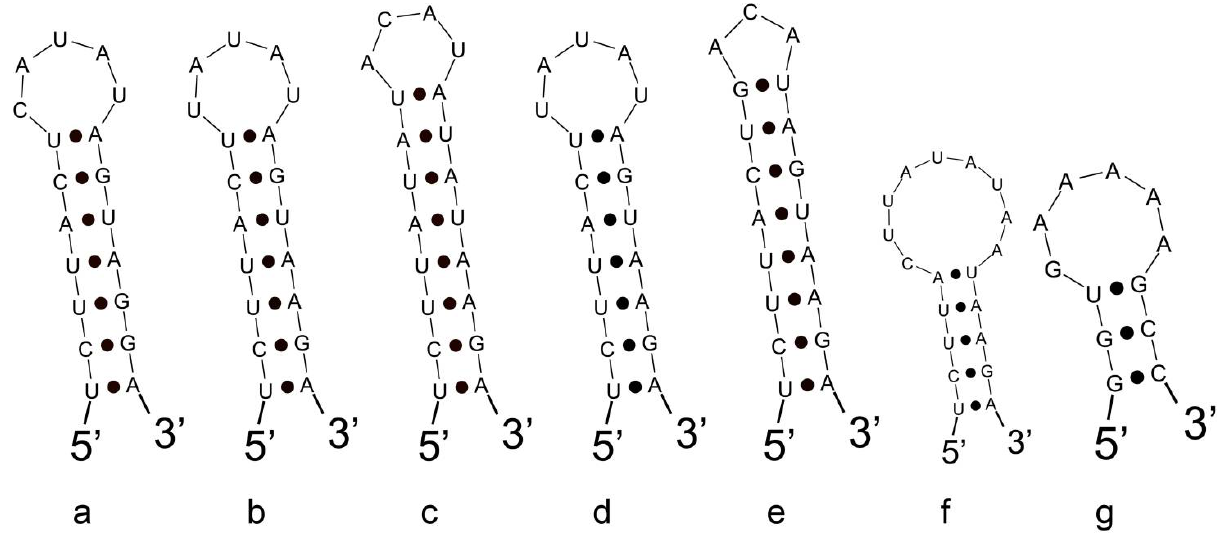
Figure 5. Box–B helices and V3 helices of Microcystis . ( a ). Box–B helix of WZU1501 and